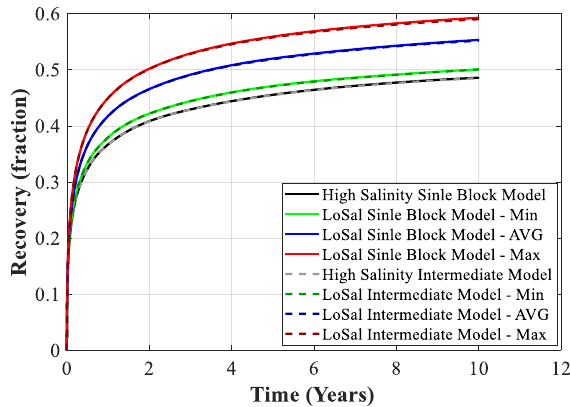
Figure 11. Comparison of the simulation results between the single block model (solid line) and the intermediate scale model (dashed line). Almost identical recoveries were obtained which indicate that single block results can be used as a representative solution to a larger scale model under the same condition.